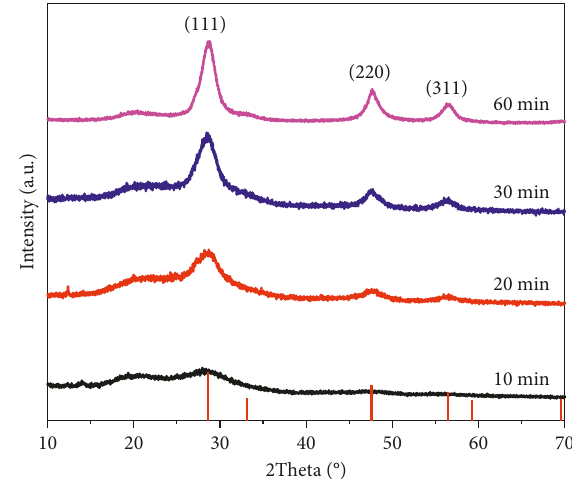
Figure 4: The effect of reaction time on p-XRD patterns of ZnS nanoparticles synthesized by the thermal decomposition of the zinc ricinoleate precursor in oleylamine/dodecanethiol (1:1) solvent mixture at 270 ° C.